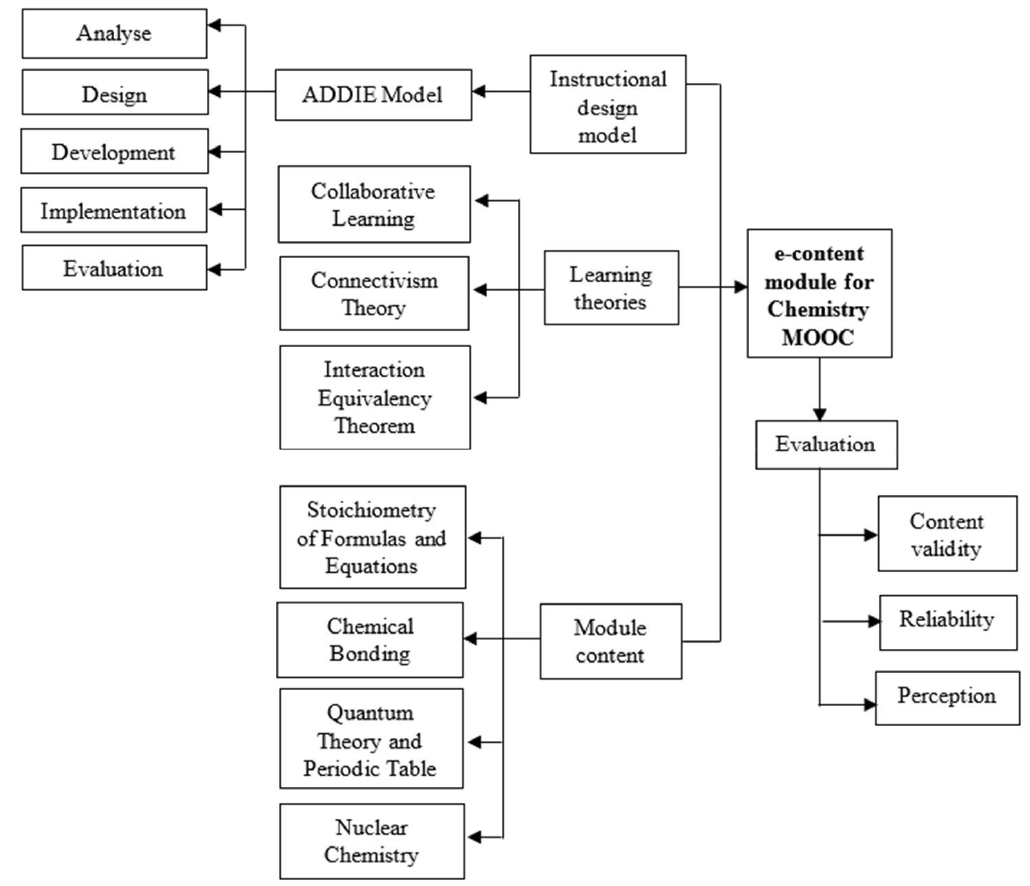
Figure 2. Conceptual framework of the study (Hamid,